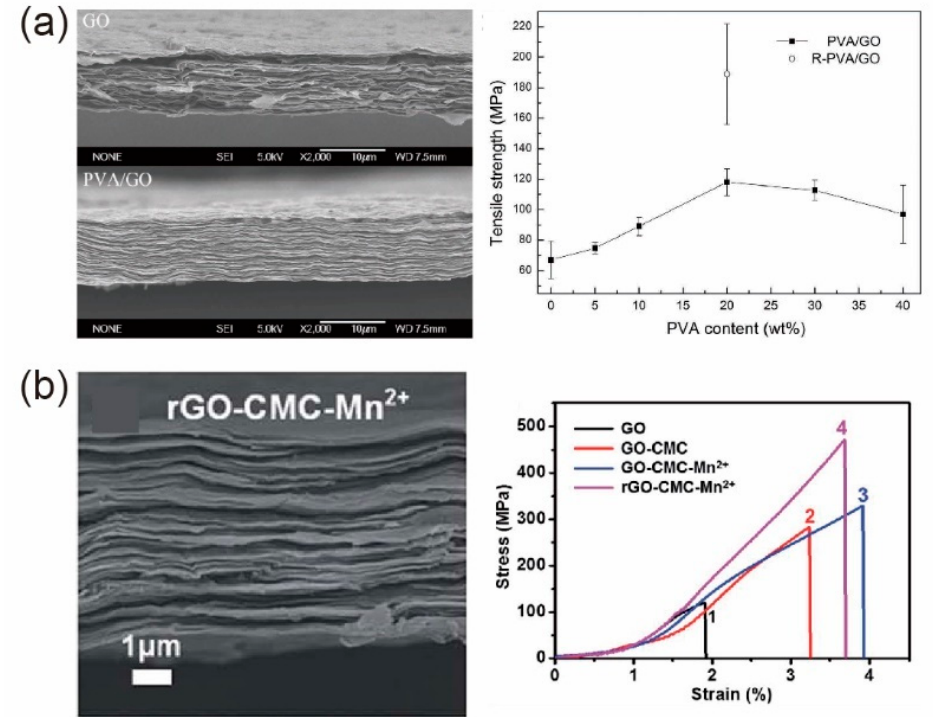
Figure 16. Nacre-like graphene/polymer nanocomposites. ( a ) PVA/GO composite films with enhanced tensile strength and fracture strain. Adapted and reprinted with permission from [191]. ( b ) GO (rGO)/CMC composites with improved mechanical properties. Adapted and reprinted with permission from [179].